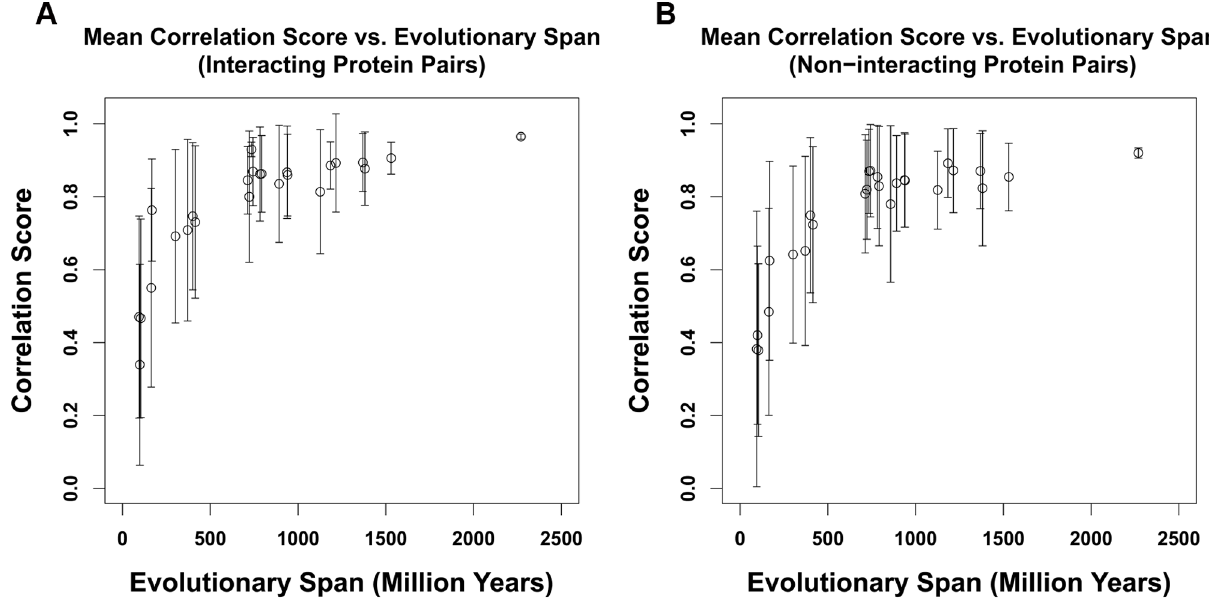
Figure 8. Average correlation vs. evolutionary span for Dataset 3. A). Interacting protein pairs. B). Non-interacting protein pairs. The evolutionary span is defined as the time since last common ancestor for the most distantly related species in the data subset. Correlation scores are mean values for each different evolutionary span, error bar shown as the standard deviation of the correlation scores within respective correlation score range. Range of conservation is defined by the range of the relevant OMA orthology sets. Time since last common ancestor is derived from the TimeTree database [35]. It is seen that the mean score is lower and the standard deviation is larger for data subsets that contain only closely related